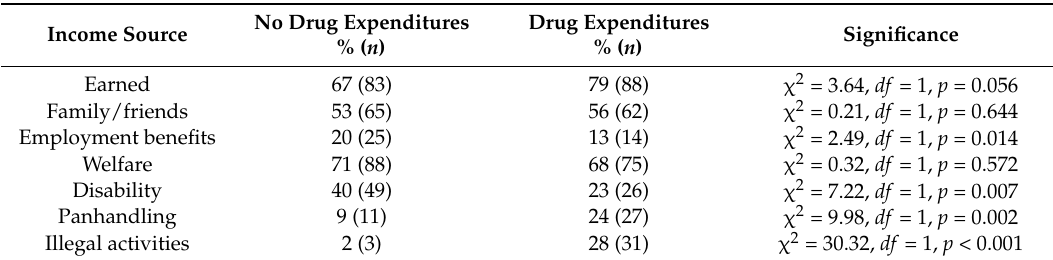
Table 5. Proportions with any 30-day income sources among those with and without any 30-day drug expenditures across three interviews.